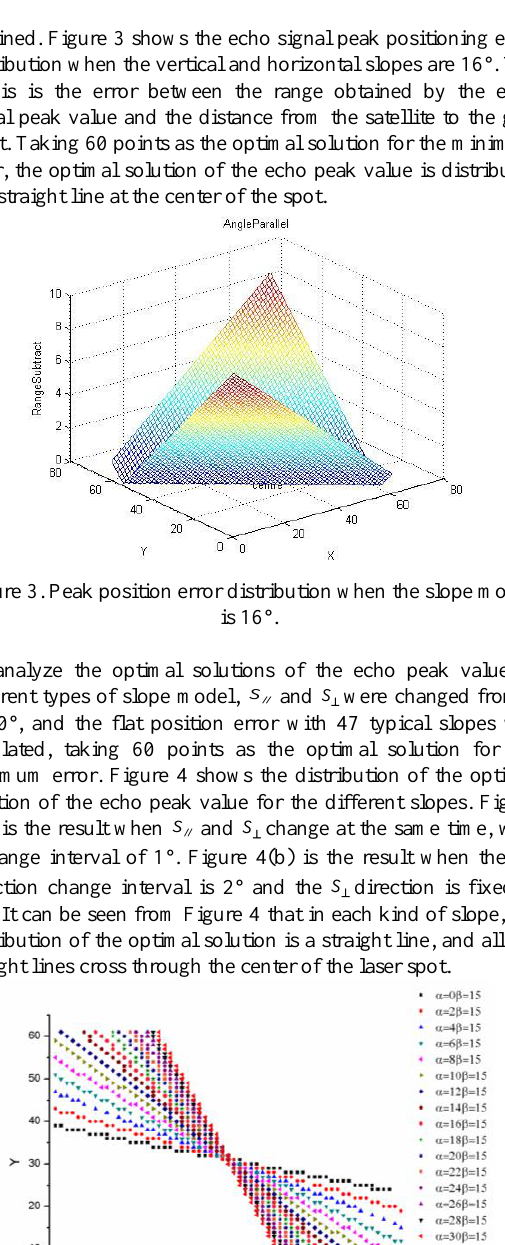
Parameter Table 2. Parameter settings of the simulation experiments The plane coordinate range on the ground was set as }300,300),{(  yxyxD xy , (approximately the size of the laser spot), and the spot area footprint was divided into a 60 × 60 grid.